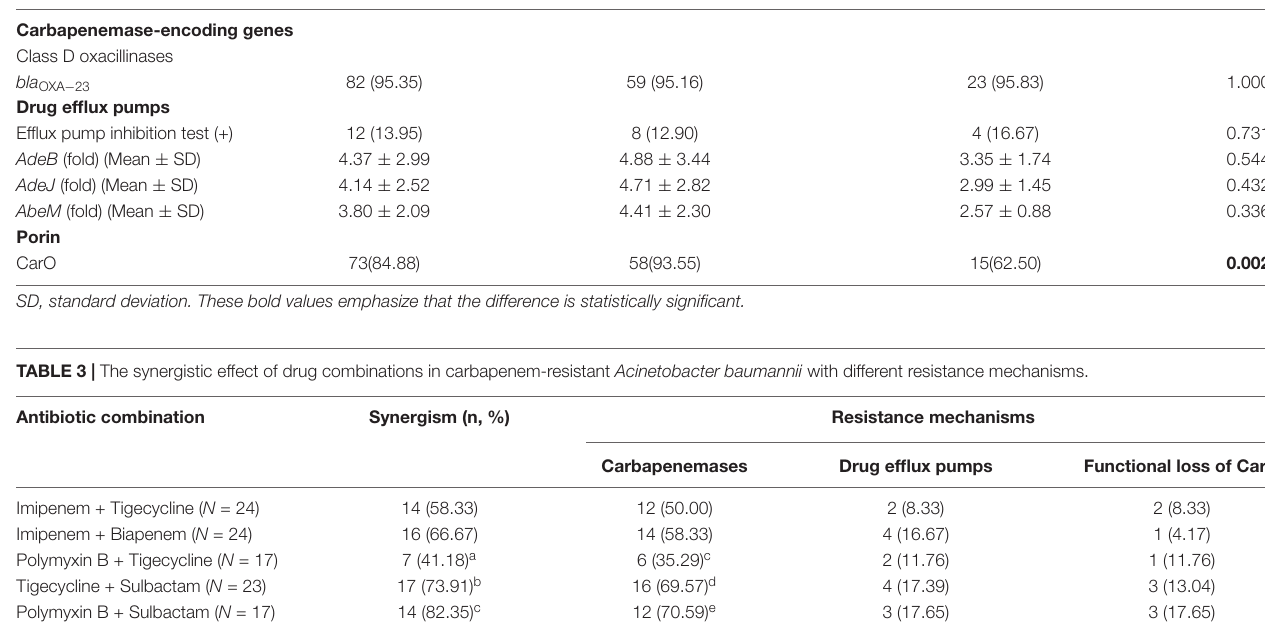
TABLE 2 | Distribution of carbapenem resistance mechanisms in clinical isolates of carbapenem-resistant Acinetobacter baumannii . All ( N = 86) (%) Treatment success ( N = 62) (%) Treatment failure ( N = 24) (%) P -value